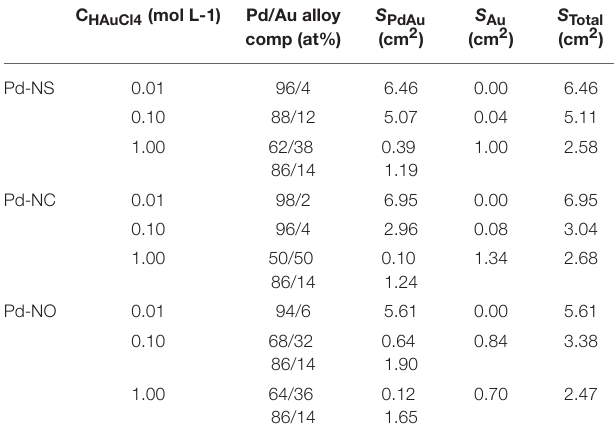
TABLE 1 | Composition of PdAu surface alloys, real electrochemical surface area of PdAu surface alloys ( S PdAu ), real electrochemical surface area of Au ( S Au ), and total real electrochemical surface area ( S Total = S PdAu + S Au ) for the Au-modified